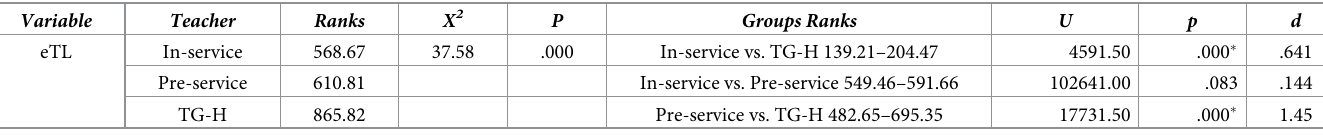
Table 4. Results of the relation and degree of association between the eTL variables.